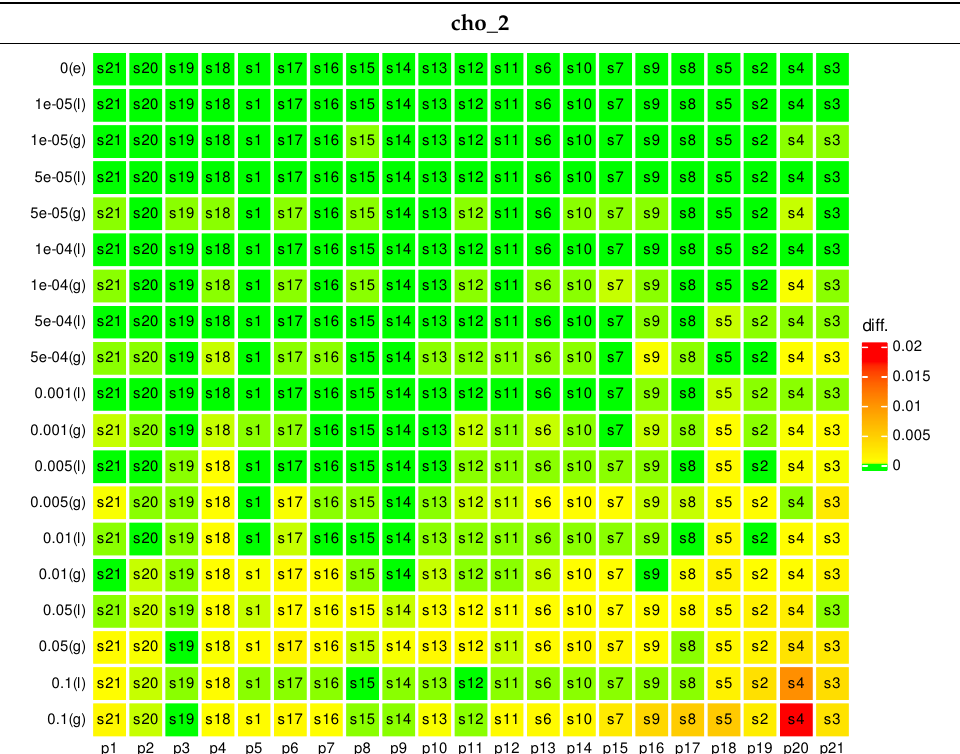
Table 20. Preferences for cho_2